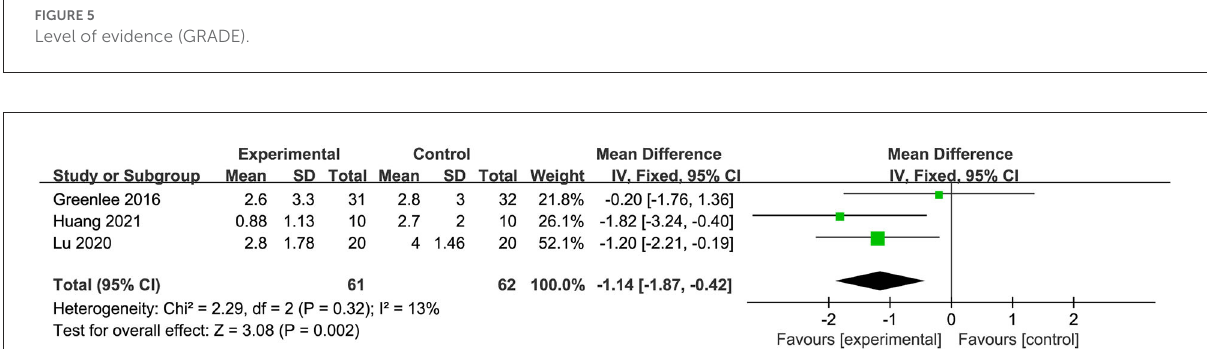
FIGURE5 Level of evidence (GRADE).